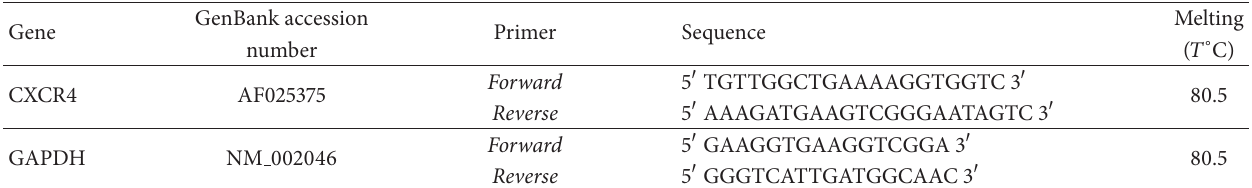
Table 1: Quantitative RT-PCR conditions and primers